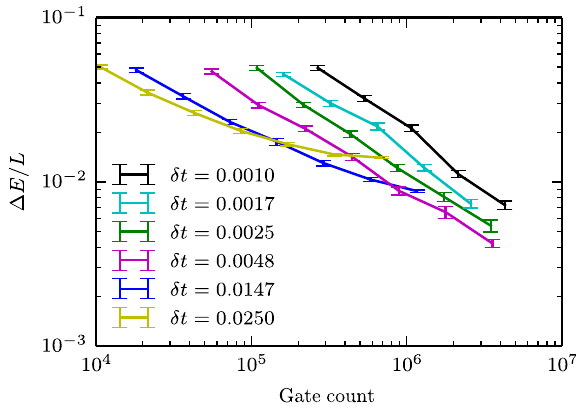
FIG. 4. Trotter errors for L ¼ 16 , averaging over 1000 instances. Here, we use a first-order Trotter decomposition.